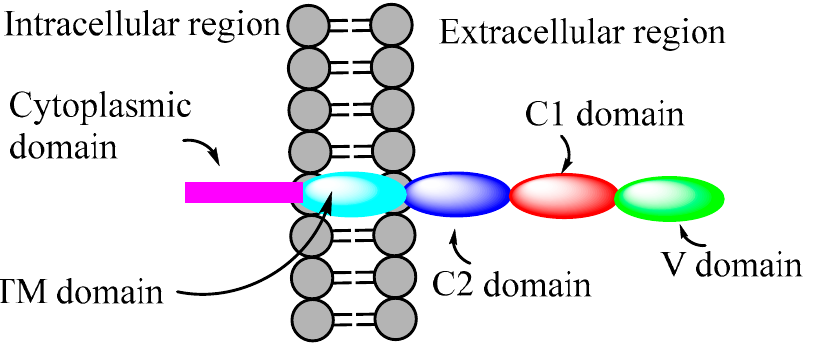
Figure 3. Schematic illustration of the structure of RAGE, showing extracellular, transmembrane, and cytoplasmic domains.